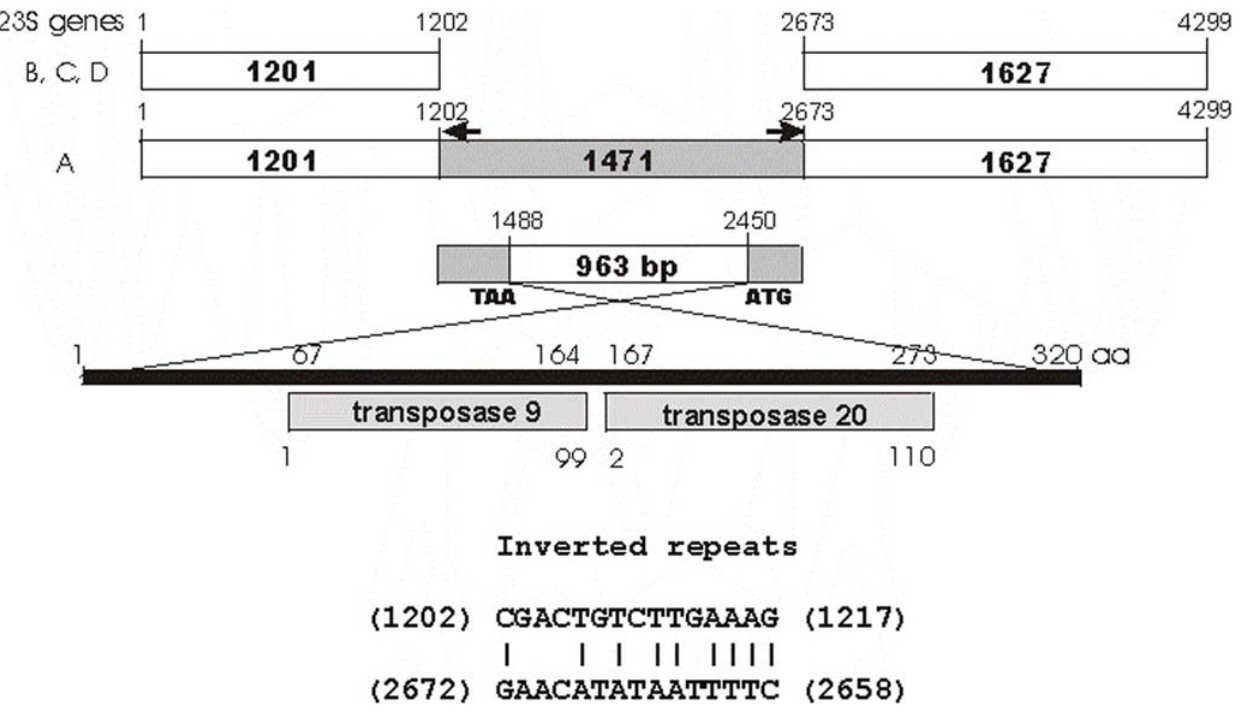
Figure 3. IVS in Nostoc sp (strain PCC 7120) 23S rRNA genes. A 1471-bp IVS flanked by partial 16-bp inverted repeats (arrows) was found in rrnA23S , which contains a 963-bp open reading frame that encodes proteins with strong homology (Expected value=7e 2 27 ) to transposases 9 and 20 in COG3547.